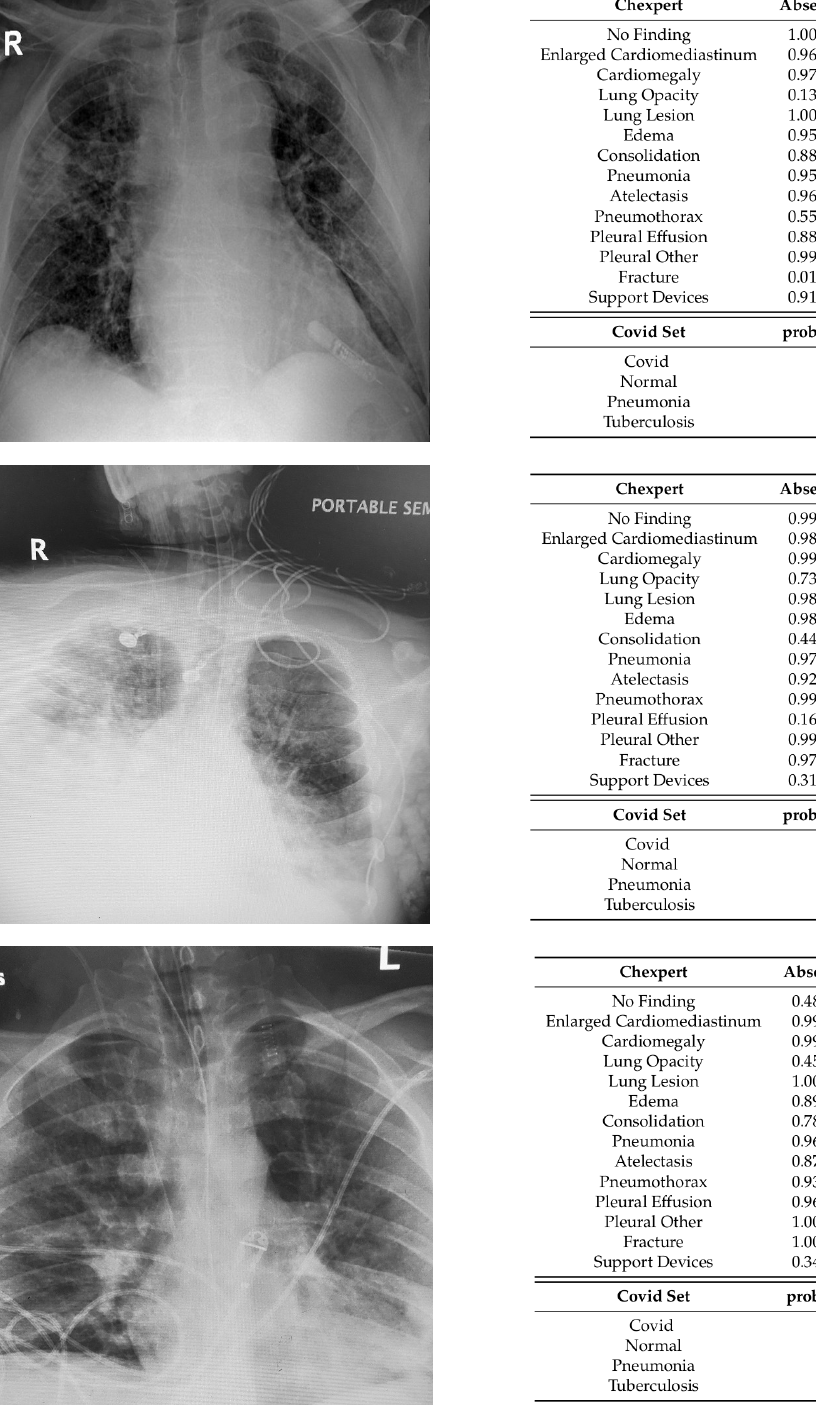
Figure 10. Three predictions of CheXpert-14 and CheXpert-COVID19 models on representative X-rays of COVID-19 patients; public available images from COVID-net dataset